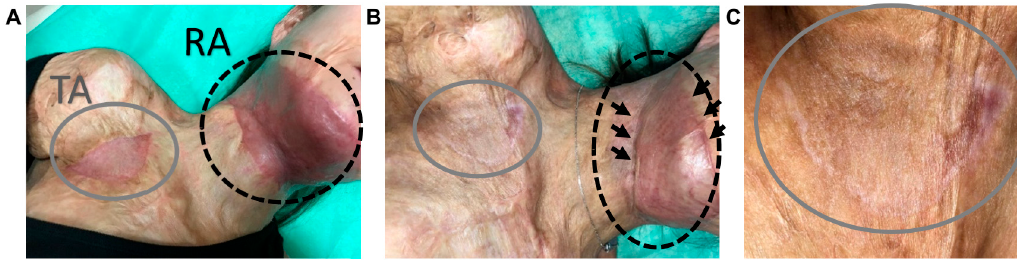
Figure 5. The second surgery: Scar excision from the tested area ( A ), ASCs seeding onto Integra ® DRT ( B ), and reconstruction of the tested area with Integra ® DRT coated by ASCs after skin staplers fixing ( C ).